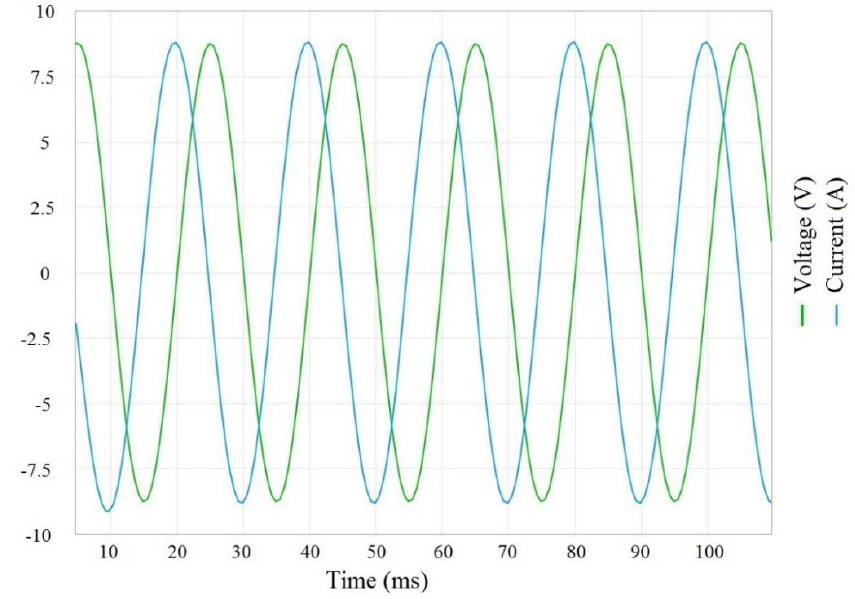
Figure 14. The PMSM stator voltage and current signals achieved in the simulation model (where the current signal overcame the voltage signal).